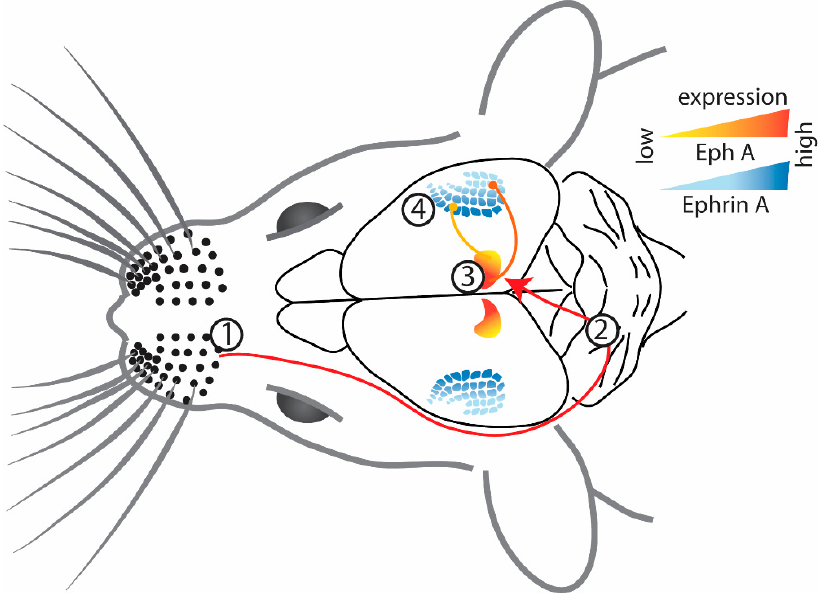
Figure 2. Schematic representation of the projections from (1) whisker barrels to (2) brainstem, (3) thalamus, and to (4) contralateral barrel cortex in adult mice [47]. Ventrobasal thalamus projects to the barrel cortex, which is guided by their complementary gradient of EphA4 receptor and ephrin-A5 ligands, respectively [49]. The endpoints of the projections are represented by a circle. Figure created using data from [47,49].